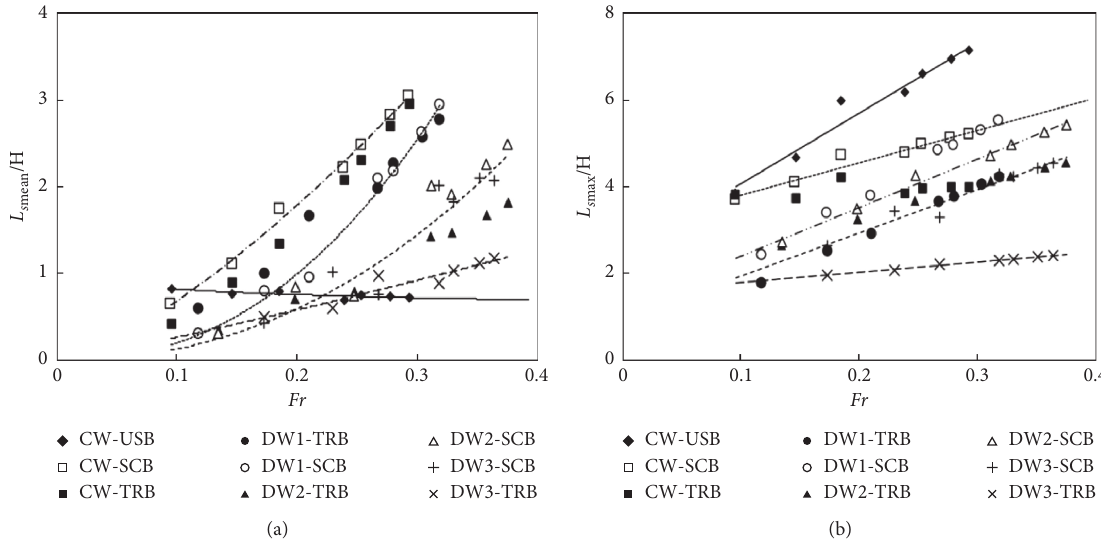
Figure 14: The changes in the dimensionless ratio with the Froude number: (a) the mean and (b) maximum lengths of the scour